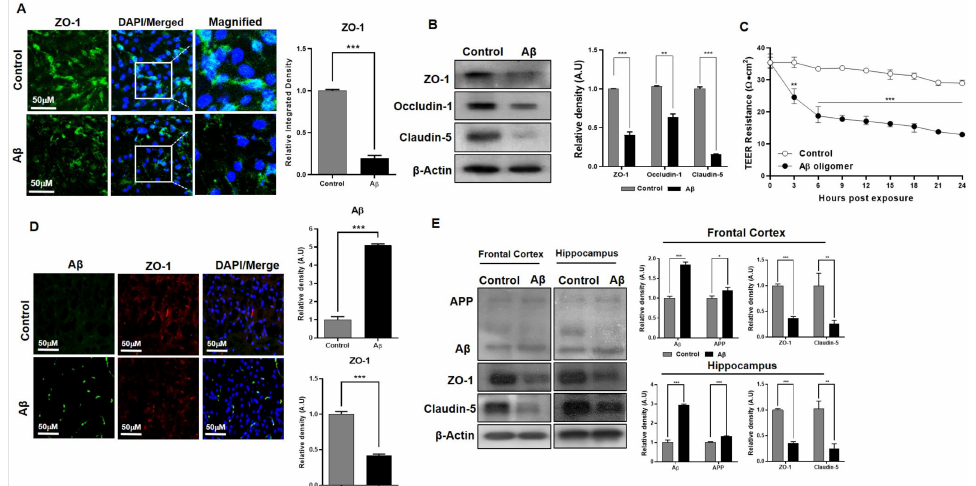
Figure 6. Amyloid beta toxicity in brain endothelial cells and astrocytes. ( A ) Confocal microscope images show the immunofluorescence of ZO-1 protein expression in control cells and amyloid beta (A β ) (1–42) peptide-treated bEnd.3 cells. ( B ) Immunoblot analysis of the expression of tight junction proteins ZO-1, occludin-1, and claudin-5 in bEnd.3 cells harvested from control and amyloid beta (1–42) peptide-treated cells. ( C ) TEER analysis of resistance measured across transwell membrane with co-culture treated with A β peptides and triple co-culture with HT22 cells transfected with pCAX APPswe/ind plasmids. TEER values were compared with untreated control cells seeded on transwells. ( D ) Immunofluorescence analysis of A β and ZO-1 expression in the cerebral cortex region of the control and A β (1–42)-injected mice. ( E ) Western blot images show the protein expression of A β , APP, ZO-1, and claudin-5 in the frontal cortex and hippocampus of the control and A β -injected mice. All data had a sample size of three ( n = 3) and three experimental repeats. Data are presented as mean ± SEM. p < 0.05 was considered to be statistically significant. * p < 0.05, ** p ≤ 0.01 and *** p ≤